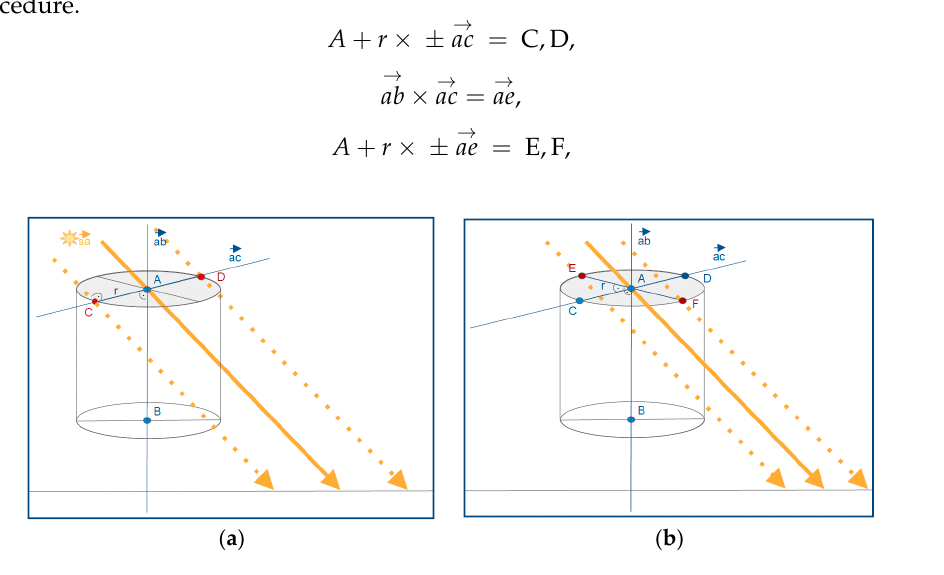
Figure 1. Cross product scheme: ( a ) The vectors (cid:1871)(cid:1853)(cid:4652)(cid:4652)(cid:4652)(cid:4652)(cid:1318) (sun–center) and (cid:1853)(cid:1854)(cid:4652)(cid:4652)(cid:4652)(cid:4652)(cid:1318) (center top–center bottom) must both be perpendicular to the new vector (cid:1853)(cid:1855)(cid:4652)(cid:4652)(cid:4652)(cid:4652)(cid:1318) through the points C,D; ( b ) The vectors (cid:1853)(cid:1855)(cid:4652)(cid:4652)(cid:4652)(cid:4652)(cid:1318) (center top–new point C) and (cid:1853)(cid:1854)(cid:4652)(cid:4652)(cid:4652)(cid:4652)(cid:1318) (center top–center bottom) must both be perpendicular to the new vector (cid:1853)(cid:1857)(cid:4652)(cid:4652)(cid:4652)(cid:4652)(cid:1318) through the points E,F.